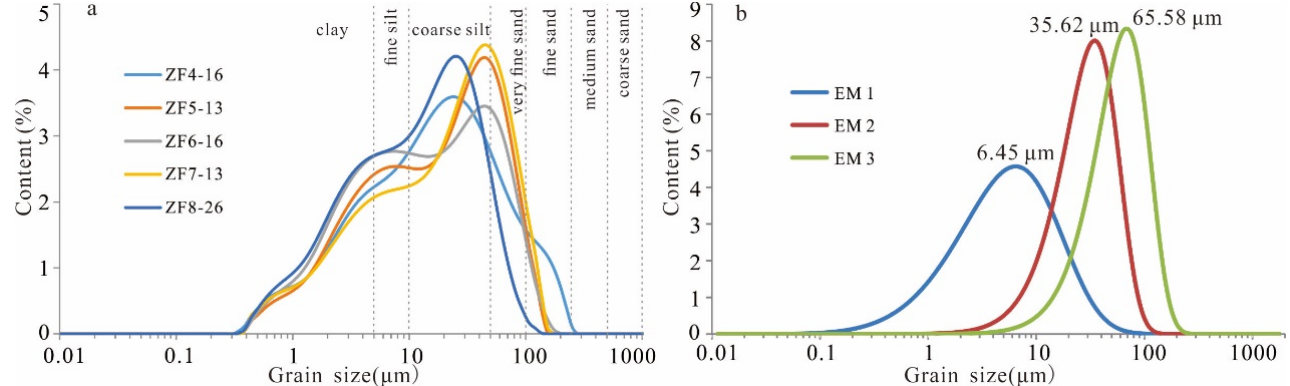
Figure 5. Frequency distribution curves of each stratum ( a ) and endmember ( b ) in the ZFS during MIS 5 period.